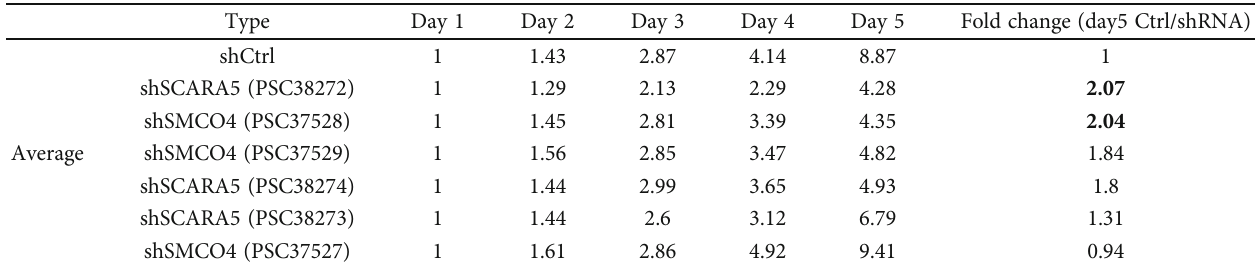
Table 3: The multiplication of cells relative to the fi rst